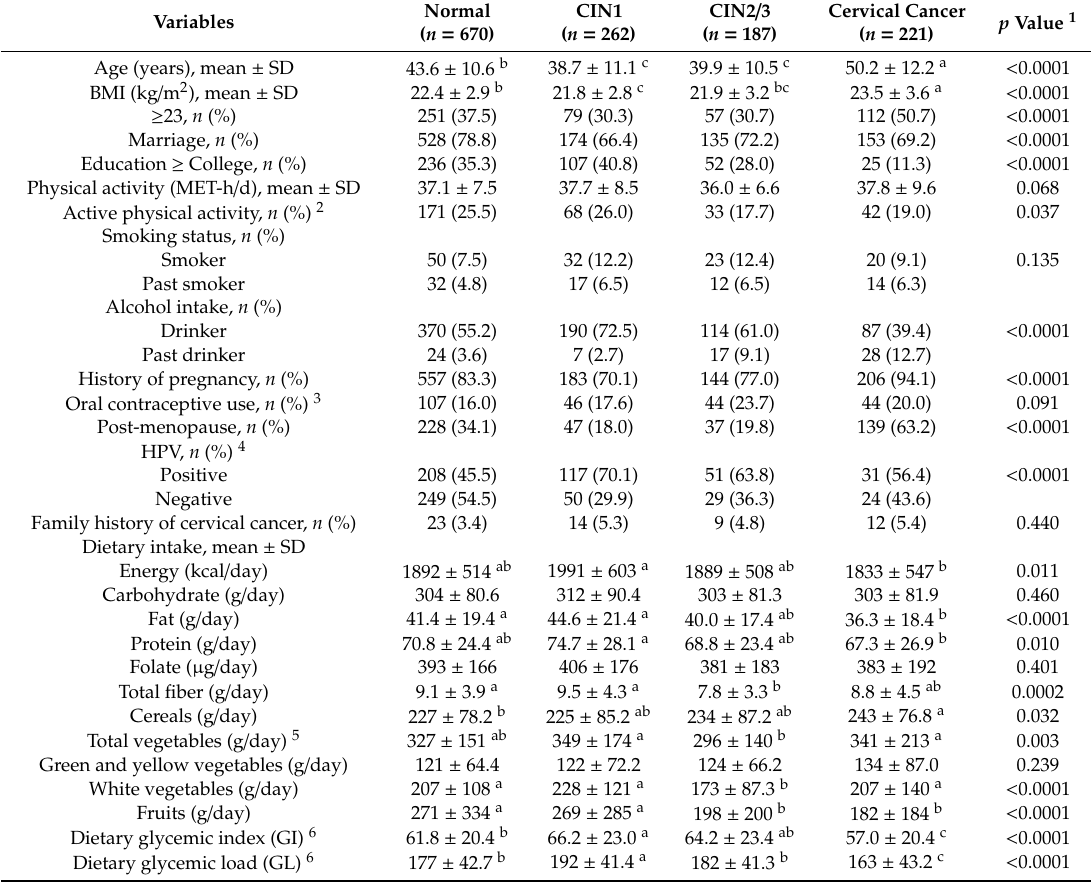
Table 1. General characteristic of study